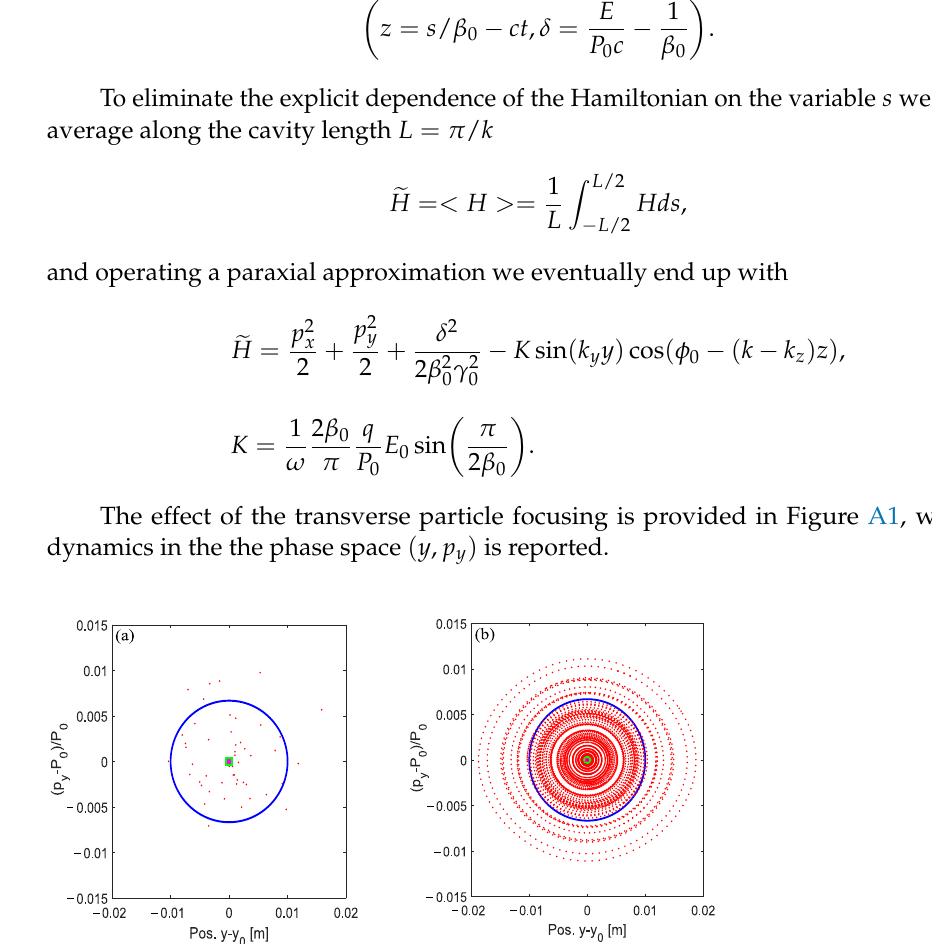
Figure A1. ( a ) Initial particle distribution in y-direction with σ y = 5 · 10 − 3 m , σ vy = 1 · 10 6 m / s , y 0 half the waveguide dimension in the y-direction and P 0 evaluated for v x = v y = 5.6 · 10 6 , v z = 2.995 · 10 8 ; the blue line is an ellipse centered at ( y 0 , P 0 ) with radius 2 σ in both the directions. ( b ) The evolution of the distribution in ( a ) governed by the Hamiltonian Equation (A9) for K = 0.0105 and a constant phase such that cos ( φ 0 − ( k − k z ) z 0 ) =